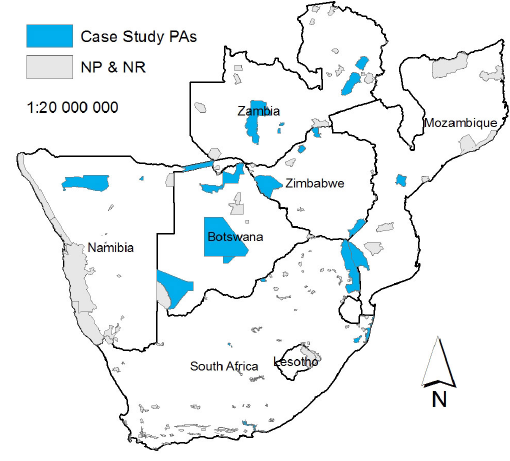
Fig. 2 . Map of southern Africa, as defined in this study, highlighting national parks (NP) and nature reserves (NR) used to analyze case study diseases. Major national parks and nature reserves in the region are shown in grey. Created with ArcGIS